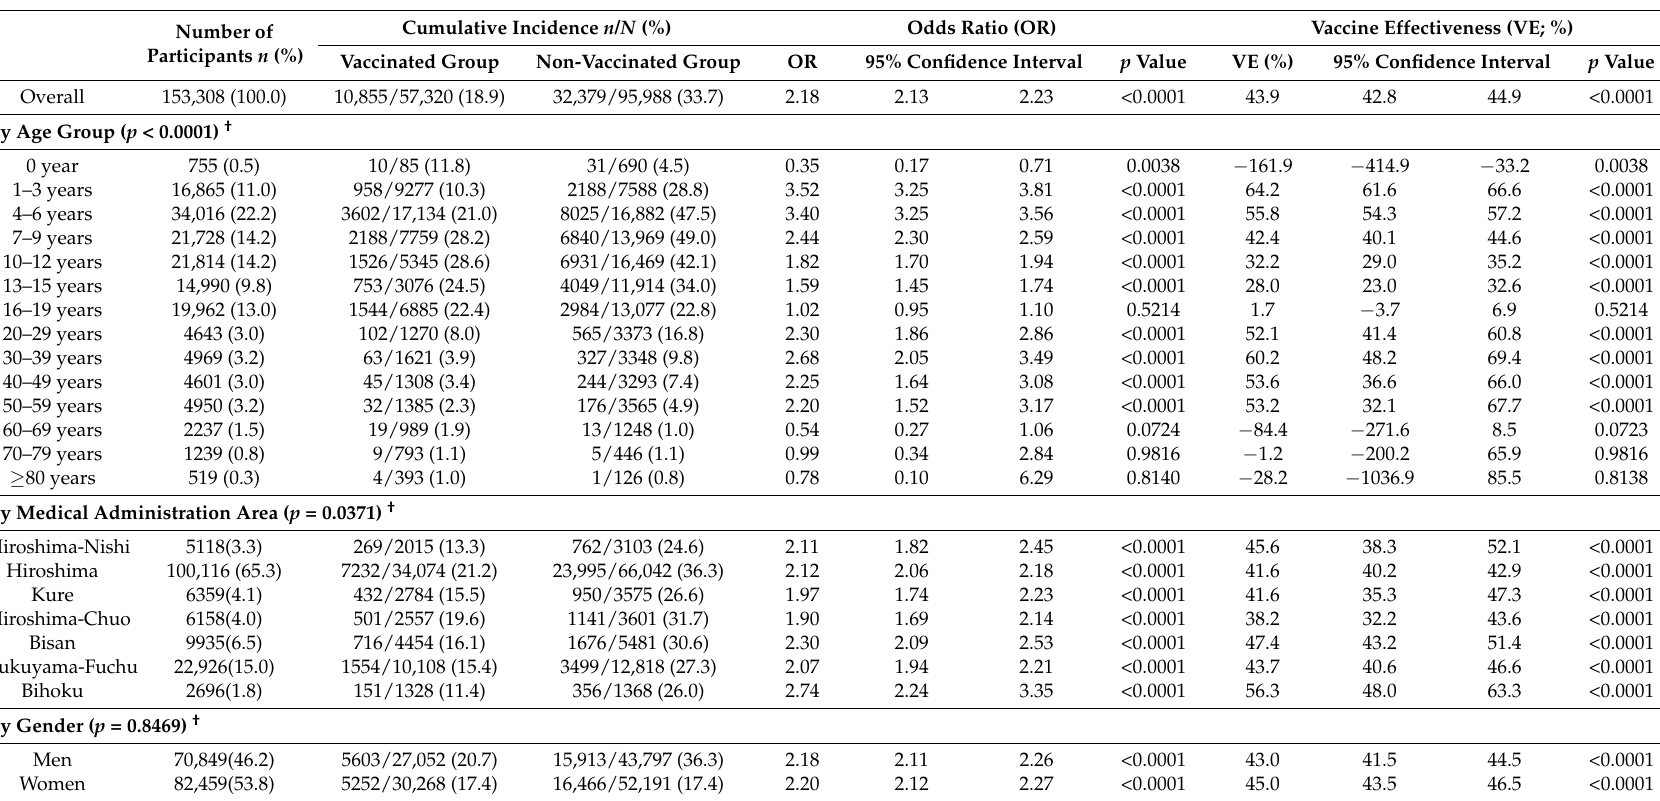
Table 3. Overall cumulative incidence of influenza, OR of cumulative incidence and VE based on vaccination status (from November 2009 to May 2010). Cumulative Incidence n / N (%) Odds Ratio (OR) Vaccine Effectiveness (VE; %) Number of Participants n (%) Vaccinated Group Non-Vaccinated Group OR 95% Confidence Interval p Value VE (%) 95% Confidence Interval p Value Overall 153,308